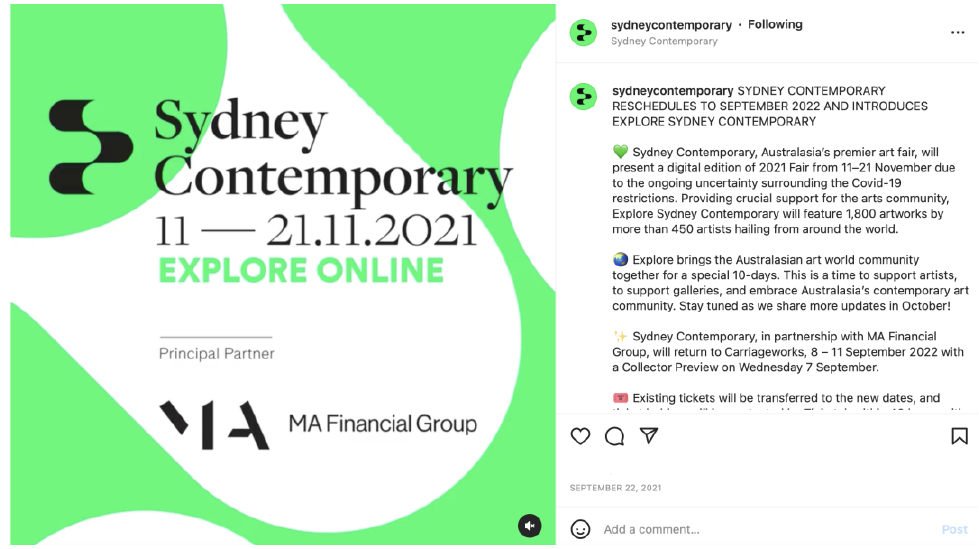
Figure 6. Sydney Contemporary Instagram post, announcing rescheduling of physical edition to 2022, and launch of 2021 digital edition, 22 September 2021. Image courtesy of Sydney Contempo- rary.